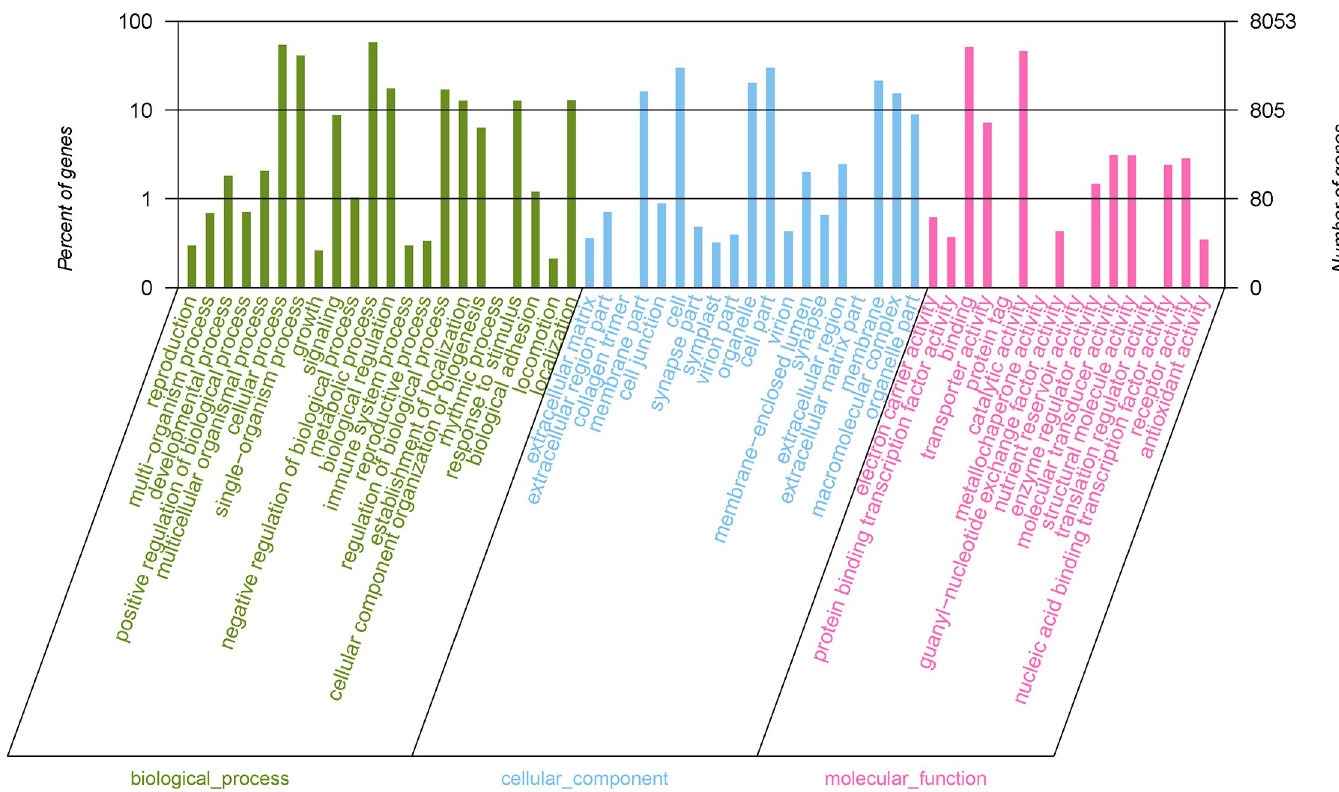
Fig 2. GO classification of S . insularis